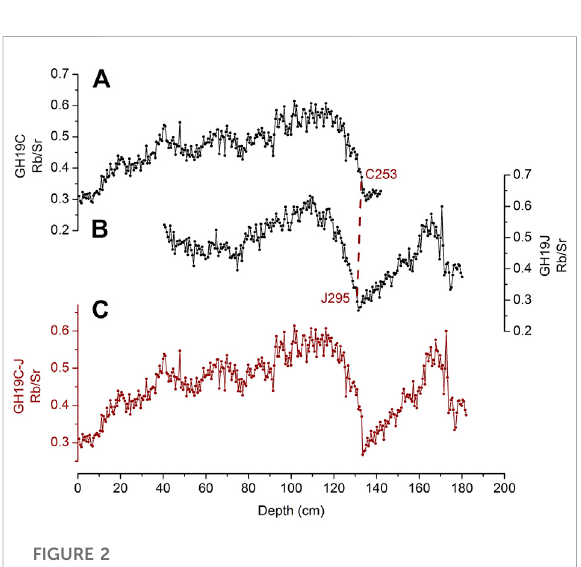
of the signi fi cant decreases in Rb/Sr ratios versus depth; this was the method used to produce (C) the connected GH19C-J data. The reason why Rb/Sr of the top of GH19J were not measured was introduced in Section